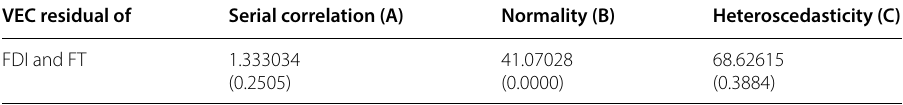
Table 8 Diagnostic tests results. Source: Calculated by authors VEC residual